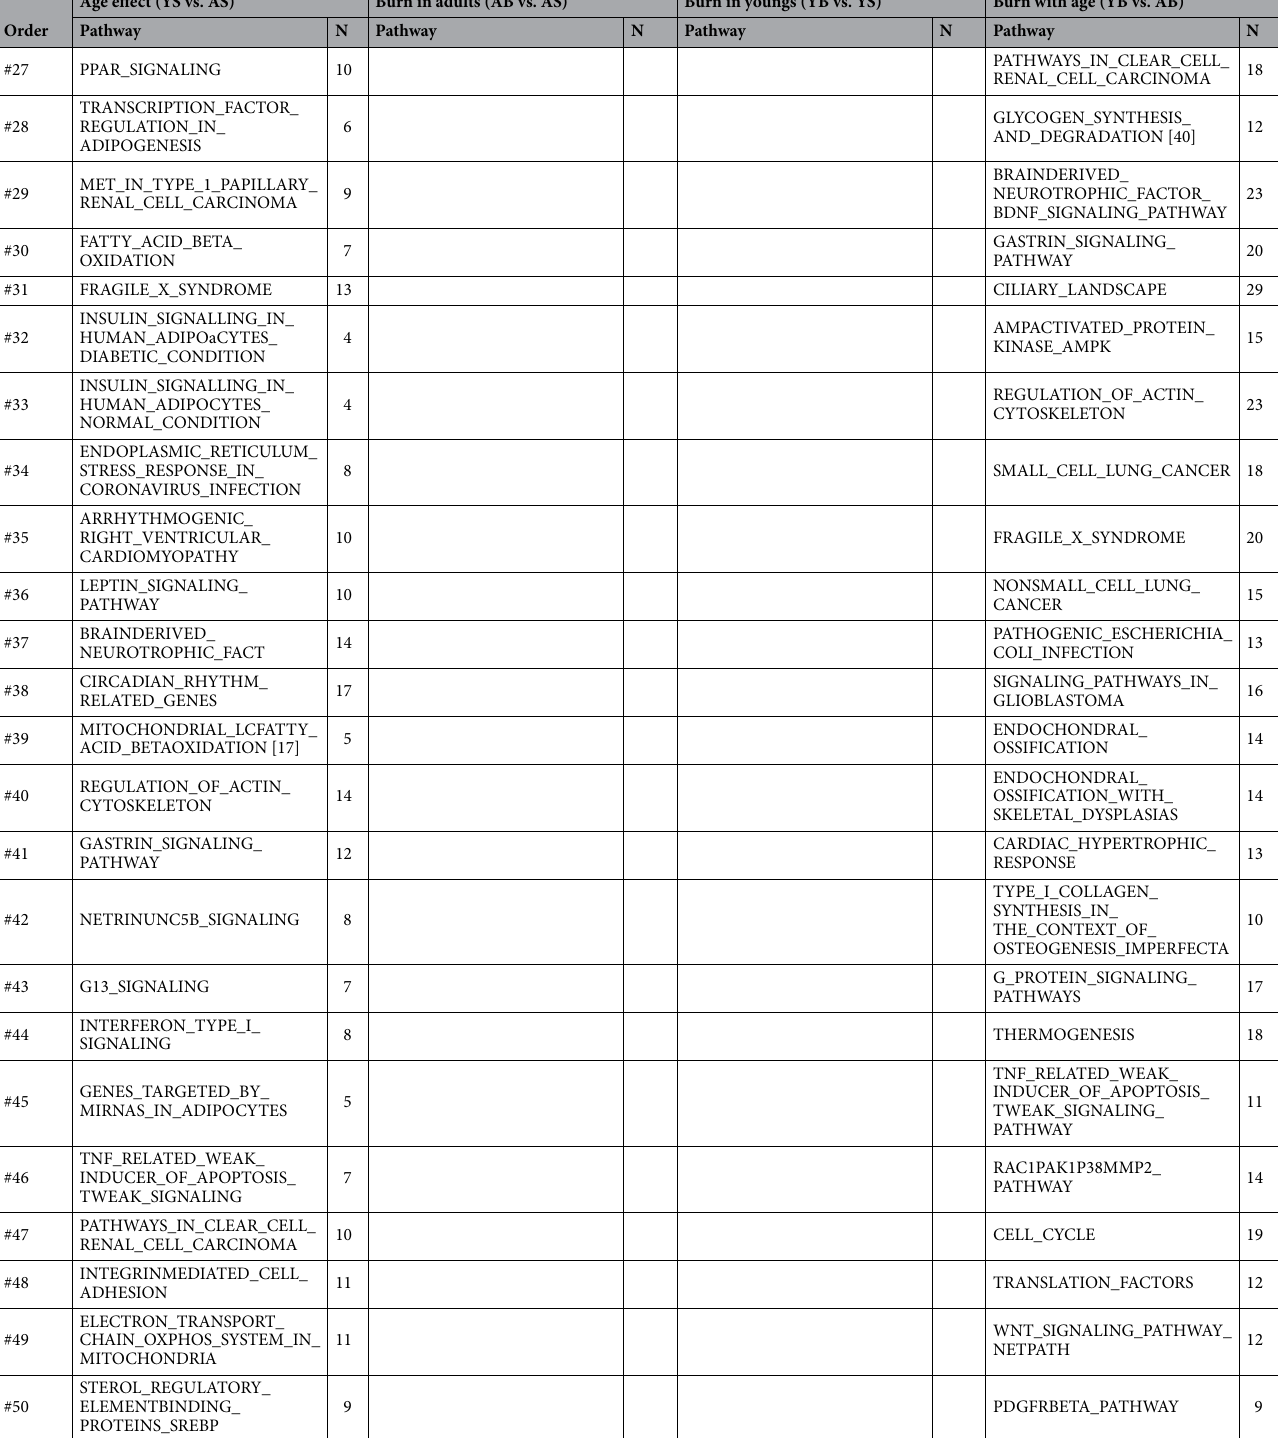
Table 3. Wiki gene sets analysis in mouse gastrocnemius between young sham (YS), young burn (YB), adult sham (AS), and adult burn (AB) groups. N: the number of altered